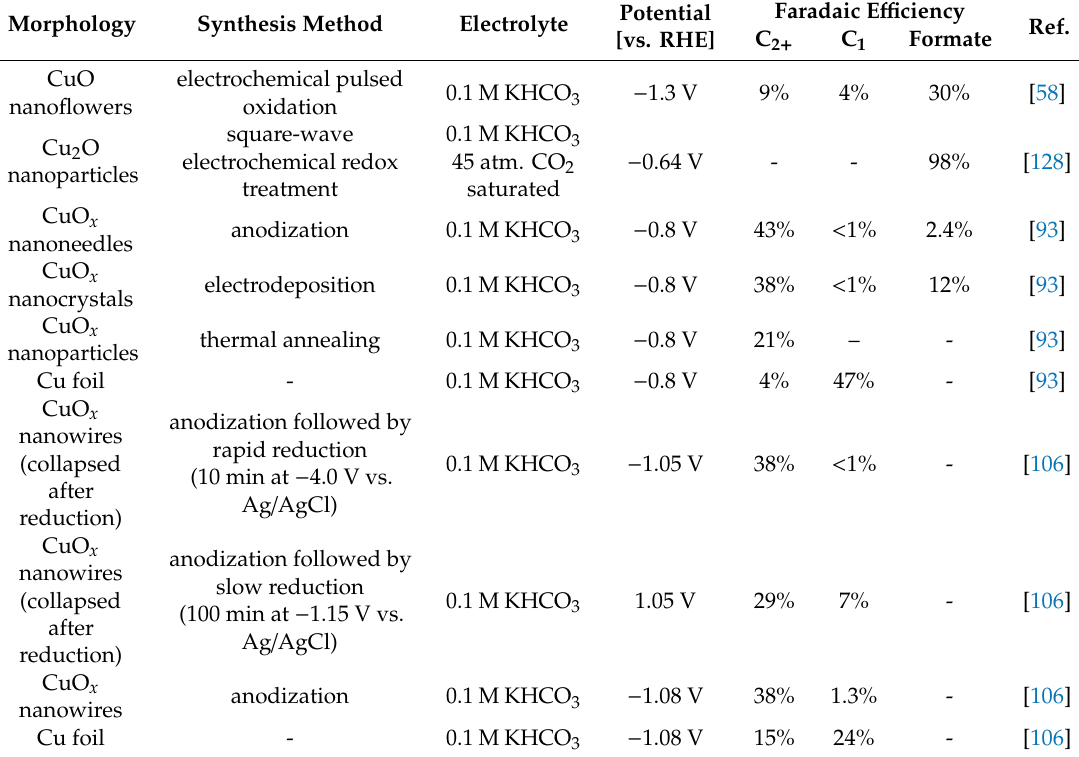
Table 2. Collective results of CO 2 RR catalyzed by electrochemically oxidized copper-based catalysts referenced in this